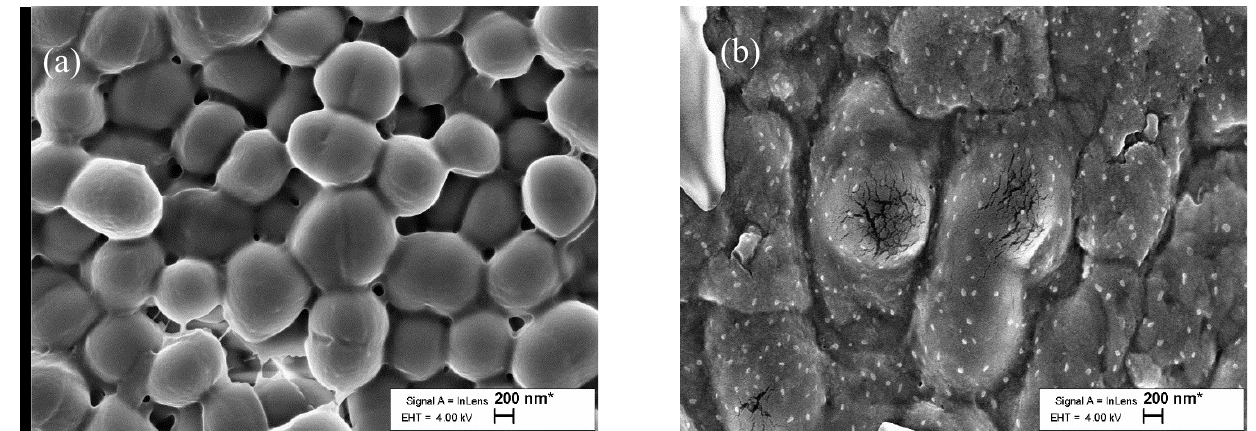
Figure 9. SEM images of E. coli biofilm on PLA films surfaces: ( a ) blank PLA film; ( b ) POM/POM film in ×10,000 magnification.